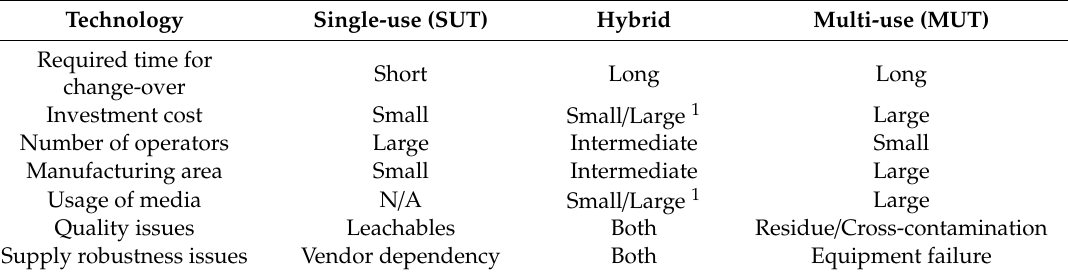
Figure 1. ( a ) Flowsheet of a typical biopharmaceutical drug product manufacturing process [15], and configuration of plants using ( b ) single-use technology (SUT) [15], ( c ) multi-use technology (MUT) [15], and ( d ) a common industrial hybrid technology option (HYB). Table 1. Characteristics of the three equipment technologies.